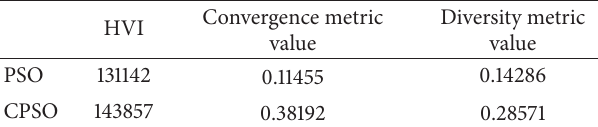
Table 4: The HVI, convergence, and diversity values produced by HoPSO.